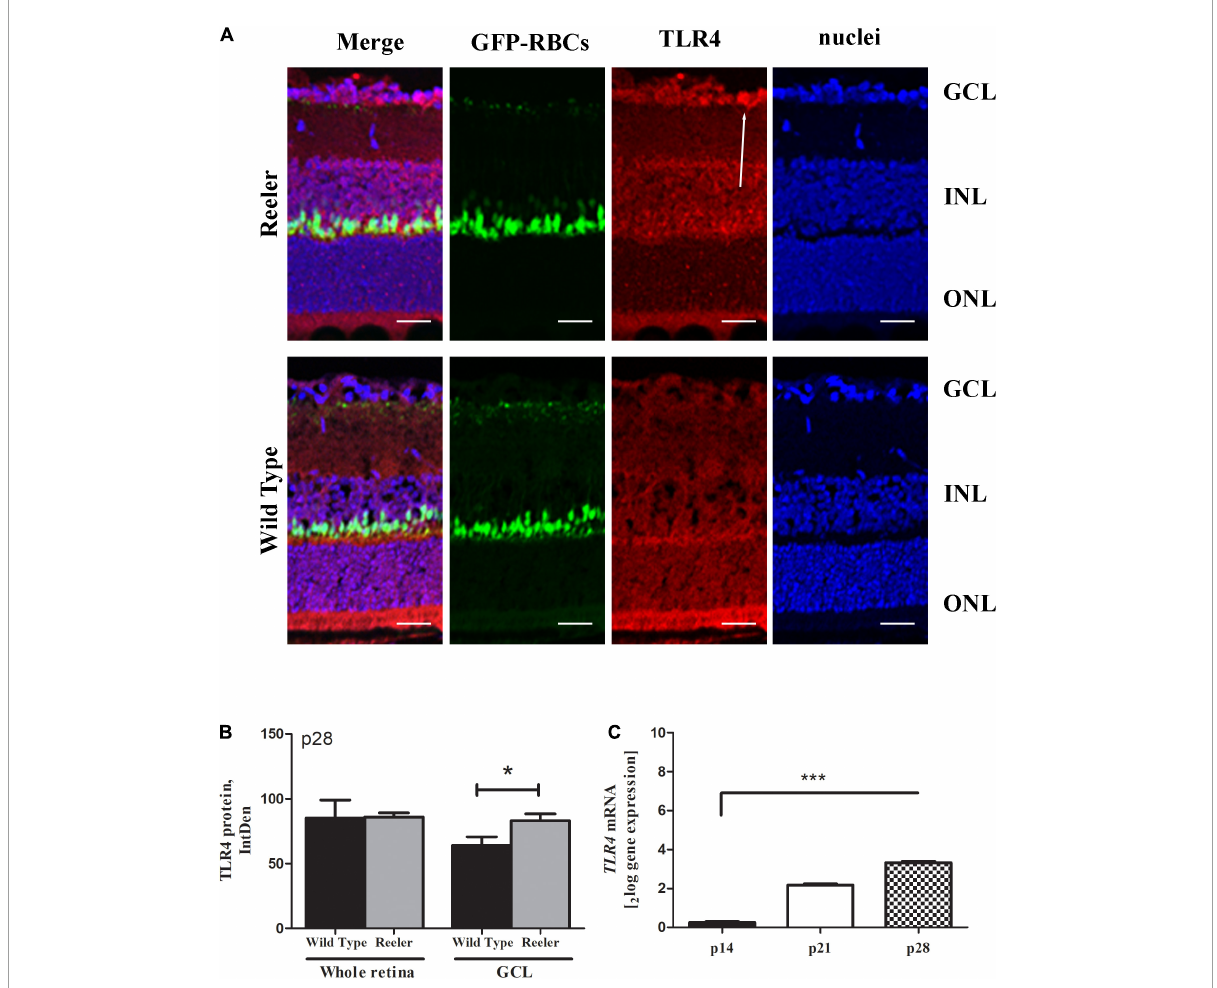
FIGURE8 TLR4 expression in Reeler retinas. (A) Representative illustrations (confocal fluorescence microscopy) showing TLR4 immunoreactivity (red) in GFP-expressing RBCs (green) and nuclear (blue) retinal sections (merge). Single-channel acquisitions are TLR4/red; GFP-expressing RBCs/green and nuclei/dapi/blue. White arrows point to a noticeable immunoreactivity of TLR4 (red) in the GCL zone of Reeler retina. (B) Histogram representative of TLR4 IntDen quantifications (mean ± SEM; Reeler vs . WT, ( p > 0.05) in whole retinas and (* p < 0.05; Kruskal Wallis analysis with post Dunn’s multiple comparison test analysis) in the GCL cell compartment). (C) mRNA retinal extracts highlighted the TLR4 transcript upregulation at p28 (*** p < 0.0001, REST analysis). Note the increased values for TLR4 in Reeler with respect to WT. TLR4, Toll-like Receptor 4; GFP, Green Fluorescent Protein; RBCs, Rod Bipolar Cells; GCL, Ganglion Cell Layer; INL, Inner Nuclear Layer; ONL, Outer Nuclear Layer; IntDen, Integrated Optical Densitometry. Magnifications: × 40; white bar: 20 µ